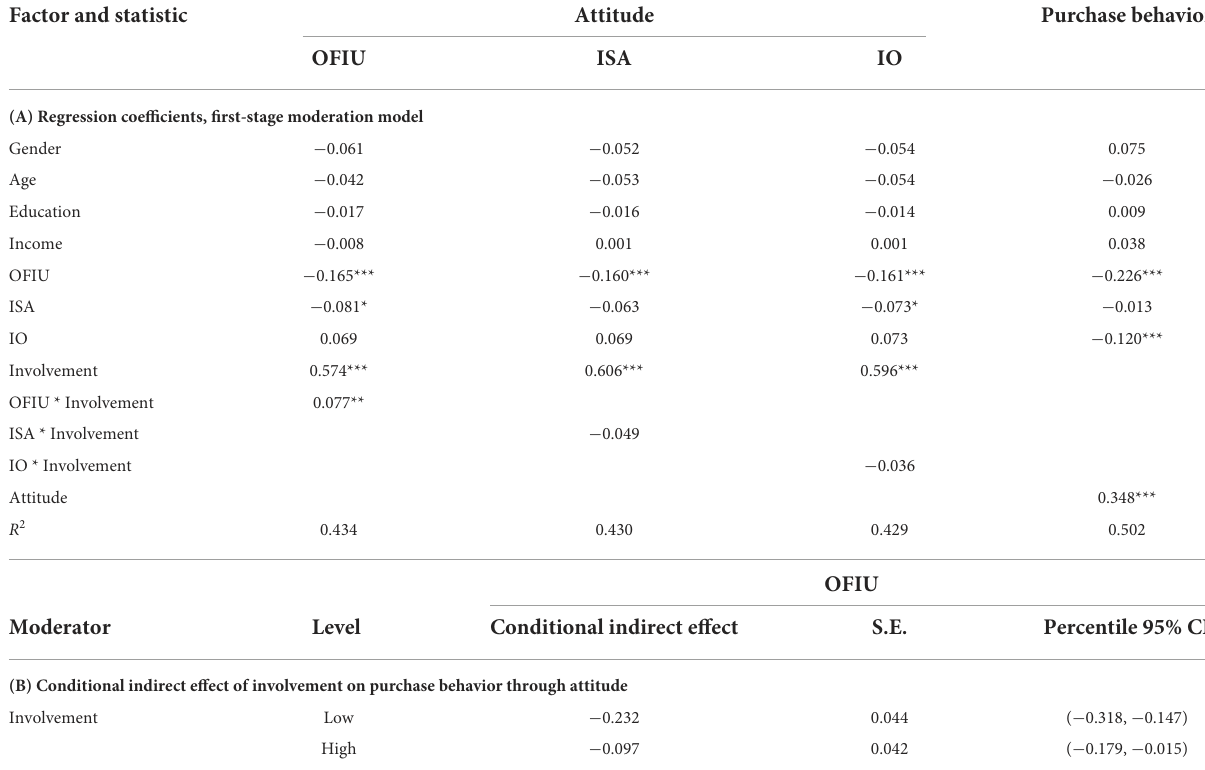
TABLE 6 Conditional indirect effects on purchase behavior. Factor and